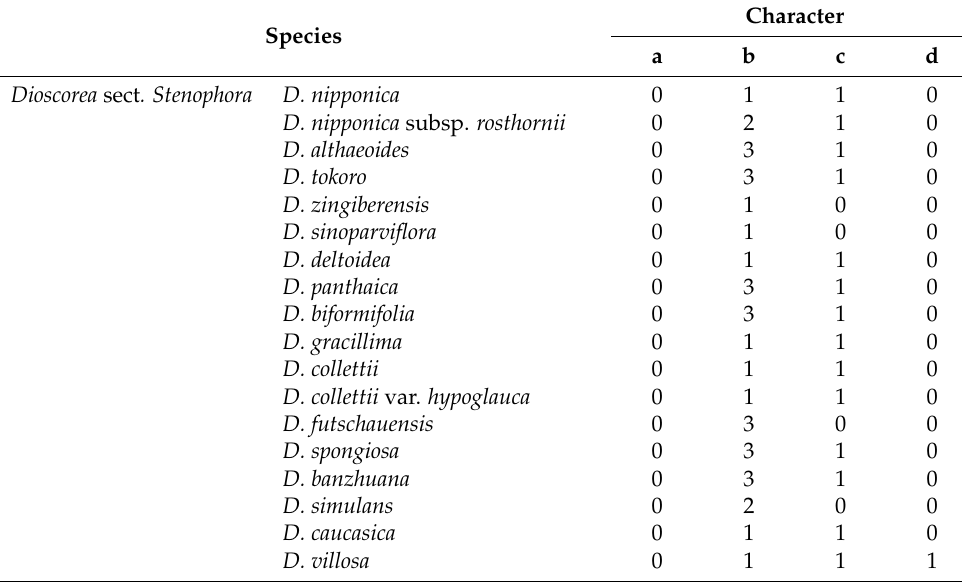
Table 3. Data matrix of morphological characters used in this